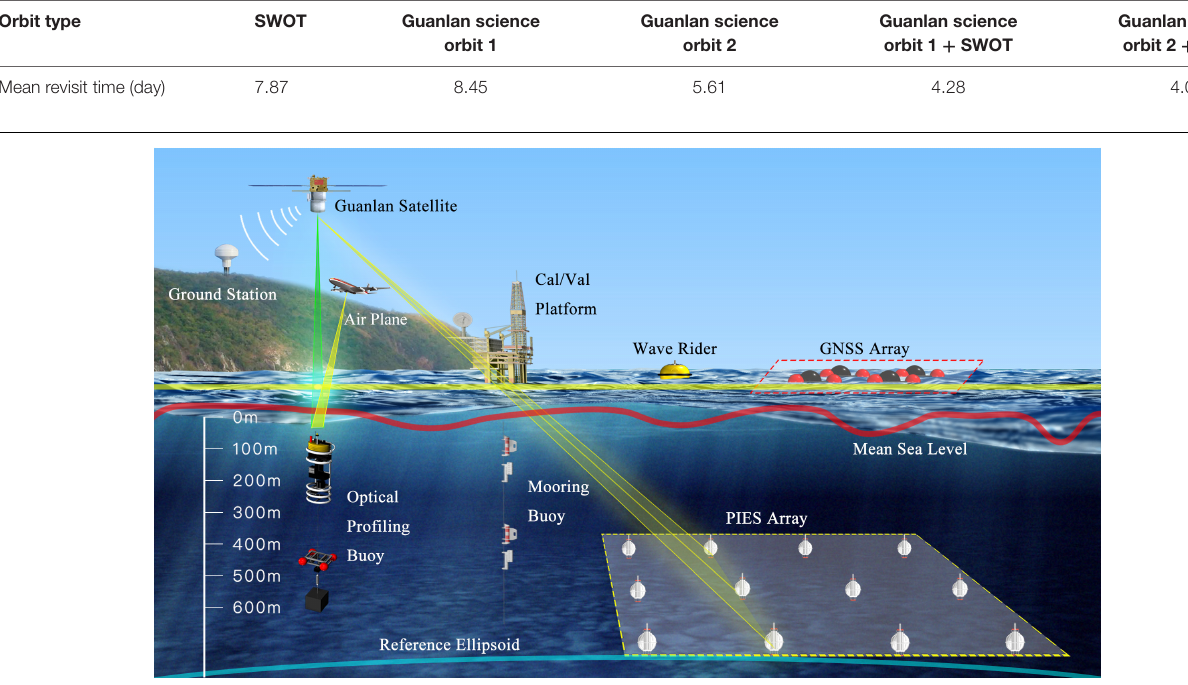
FIGURE 10 | A schematic illustration of calibration/validation facility for the Guanlan IA and OL.